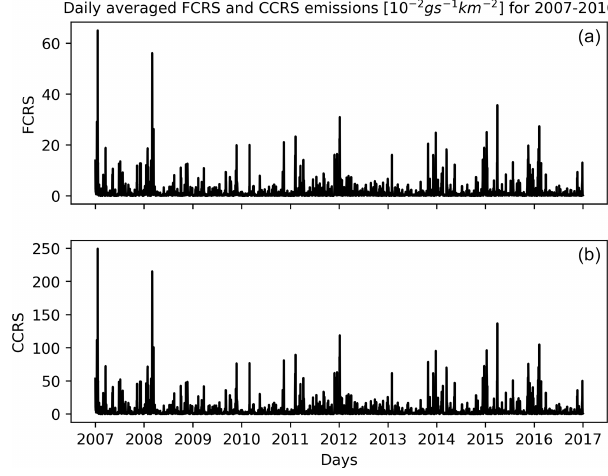
Figure 3. Domain-averaged annual cycle of monthly averages of FCRS and CCRS WBD emission fluxes for 2007–2016 (in 10 − 2 gs − 1 km − 2 ).